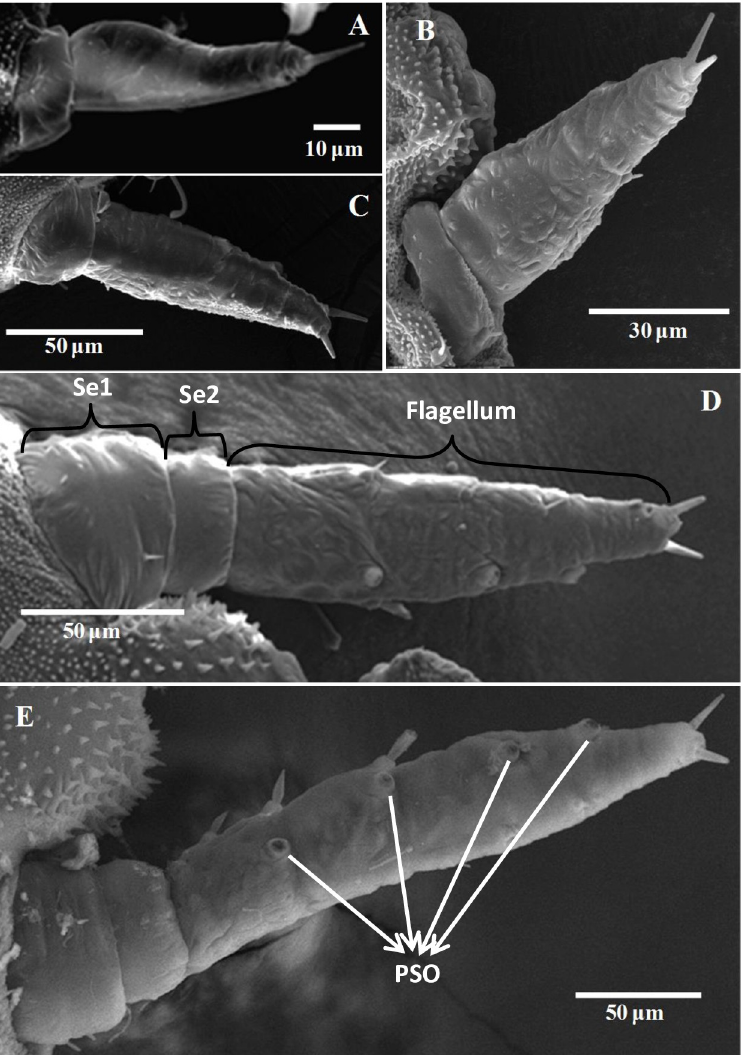
Fig 1. General morphology of the antennae of the immature Diaphorina citri . (A-C) SEM photographs of the first-, second- and third-instar of D . citri nymphal antennae with two segments. (D-E) SEM photographs of the fourth- and fifth-instar of D . citri nymphal antennae with three segments. PSO, partitioned sensory organ; Se1, the first segment of the antennae; Se2, the second segment of the antennae.